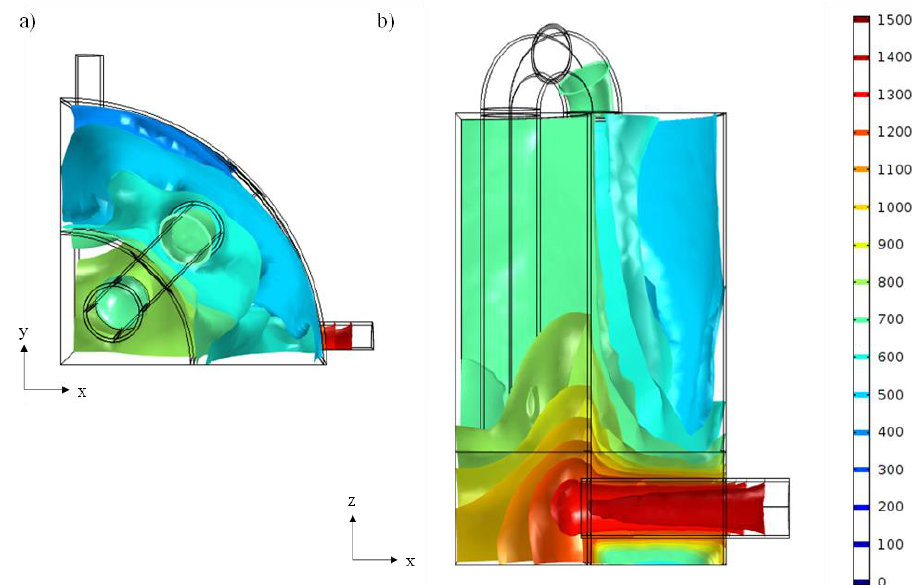
Figure 8. Temperature profile of CHIRS (I) in the ( a ) XY plane and ( b ) XZ plane.